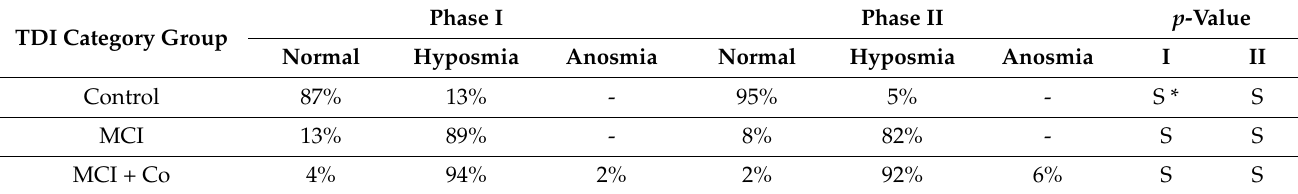
Table 1. Percentage (%) of participants per olfactory category in each participant group and across phases.